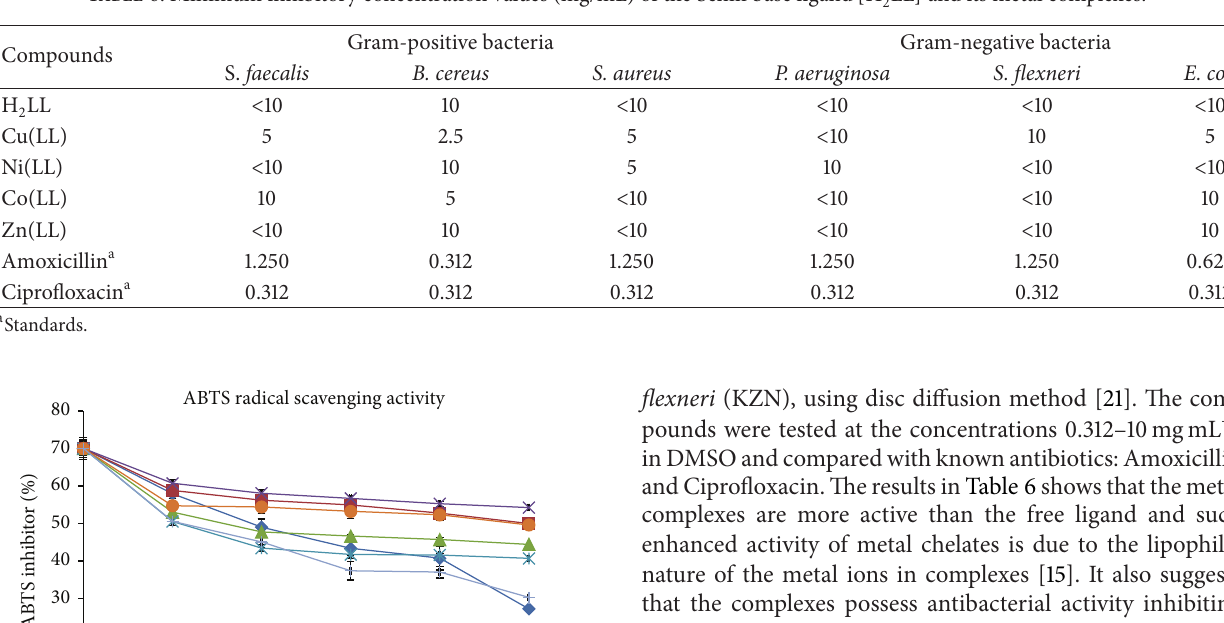
, 𝜇 M) of standard drugs and H 50 Compounds